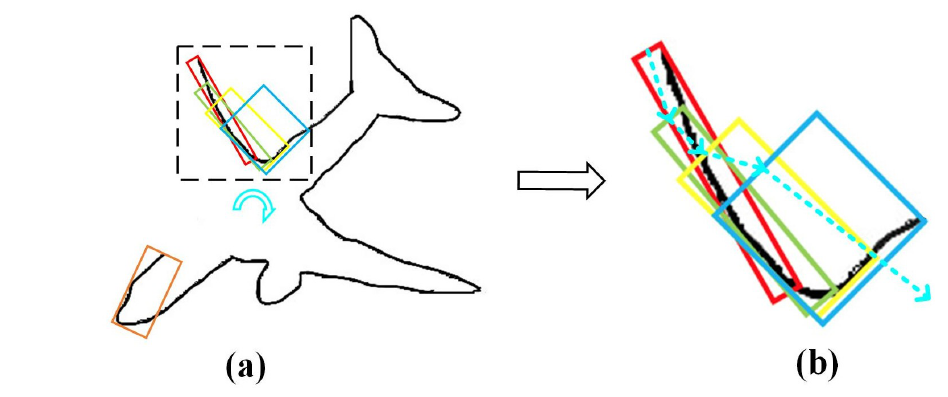
Figure 8. ( a ) The design principles of the MBR for the occluded contour of the target; ( b ) the content of the dashed box in Figure ( a ) and the detailed walking principles of the MBR, as shown by the fluorescent blue arrow in Figure ( b